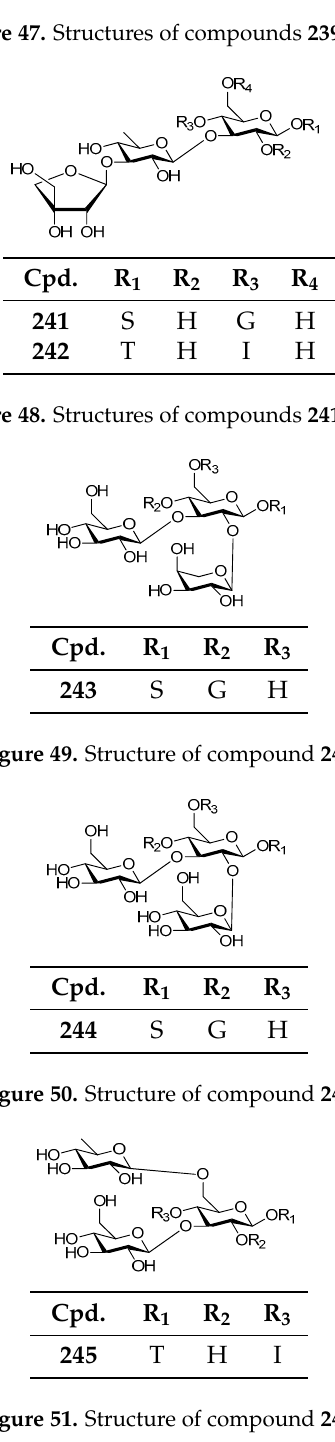
Figure 52. Structure of compound 246 .